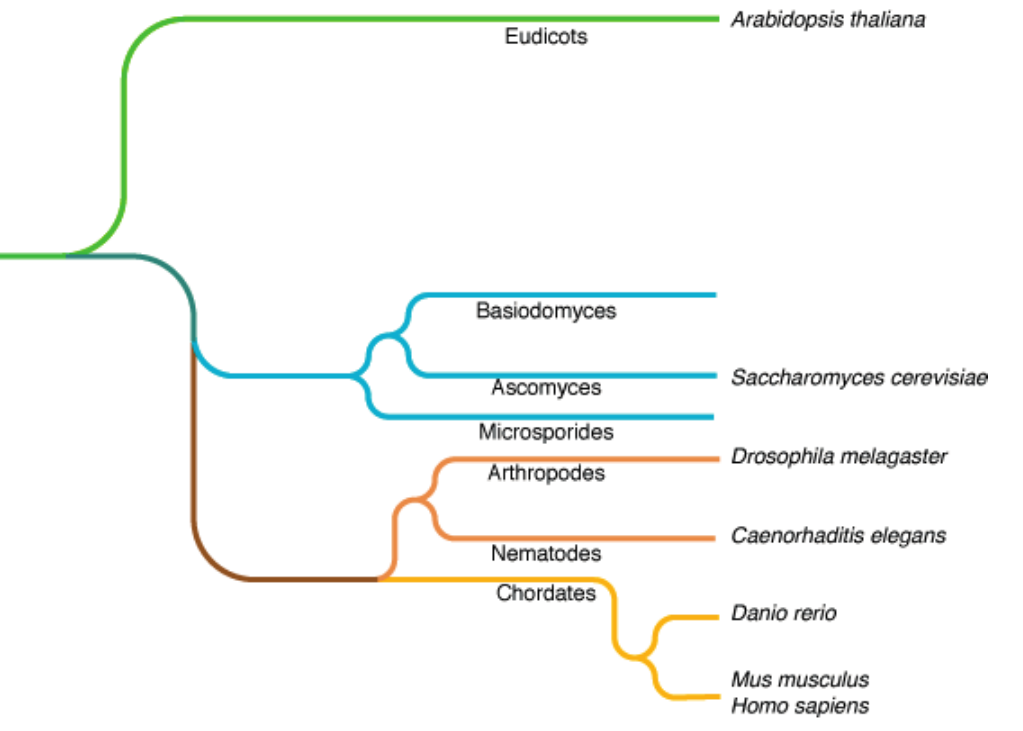
Figure 1. Phylogenetic tree of eukaryotes representing the distribution of cellular biology